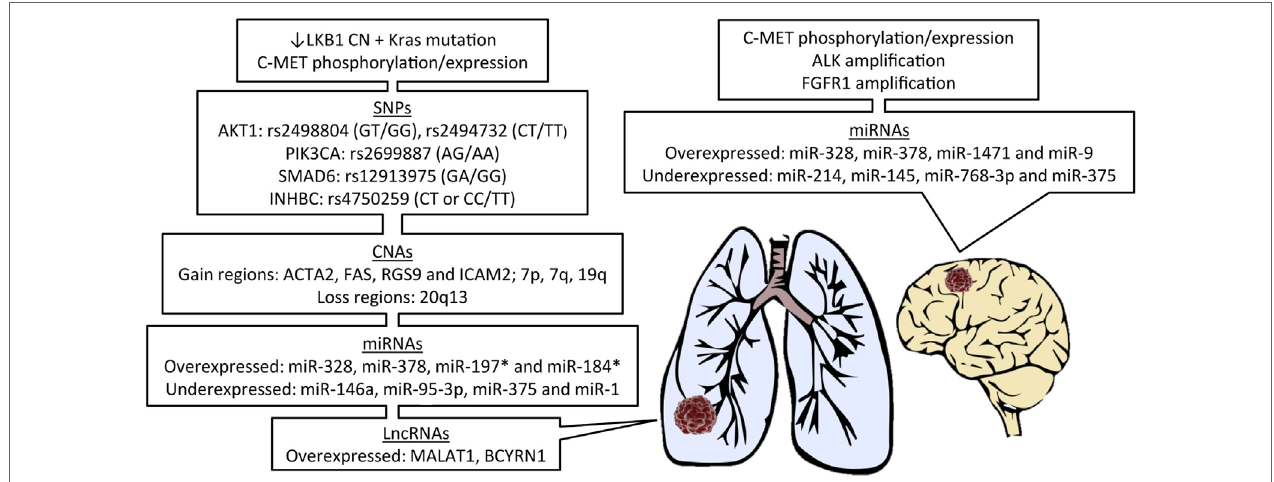
FiGURe 1 | Features of primary lung cancer from patients known to develop brain metastasis and potential biomarker candidates. LKB1, liver kinase B1; CN, copy number; SNPs, single-nucleotide polymorphisms; CNAs, CN alterations; miRNAs, microRNAs; lncRNAs, long non-coding RNAs; *in EGFR-mutant